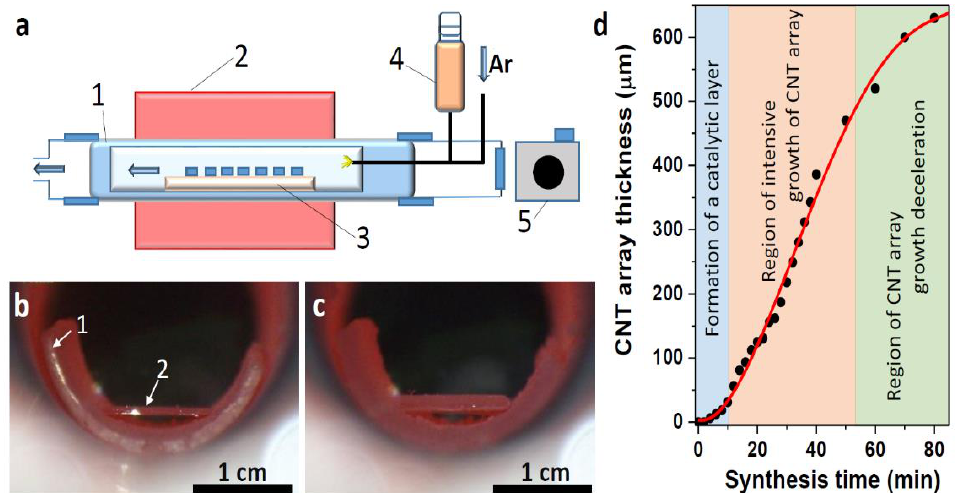
Figure 1. Scheme of the CVD reactor ( a ). The numbers on the scheme indicate: 1—quartz tube reactor, 2—high-temperature tubular furnace, 3—quartz boat with silicon substrates, 4—injection device, 5—video registration system. Image of the edge of a quartz boat with a silicon substrate after 4 min ( b ) and 40 min ( c ) of CNT synthesis. The numbers indicate: 1—quartz boat; 2—silicon substrate edge. The growth rate of the CNT array ( d ).